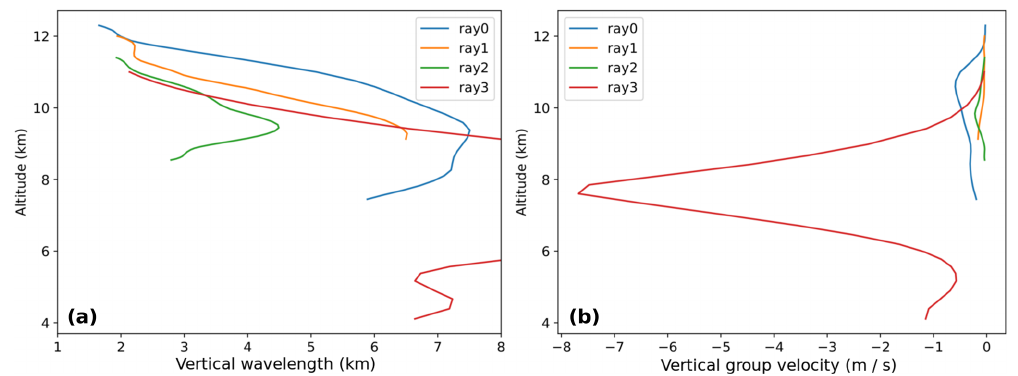
Figure 7. Vertical wavelength (a) and vertical group velocity (b) along the back trace for ray nos. 0 to 3 as calculated by GROGRAT. The leftmost plot is cut at 8km in order to achieve readability for ray nos. 0 to 2.